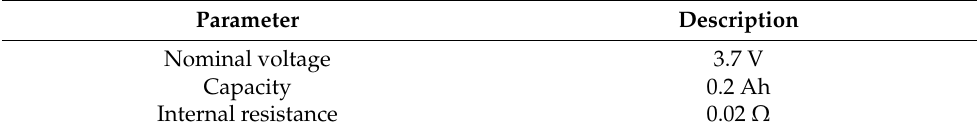
Figure 3. External current for the battery pack. Table 3. Simulation battery parameters.